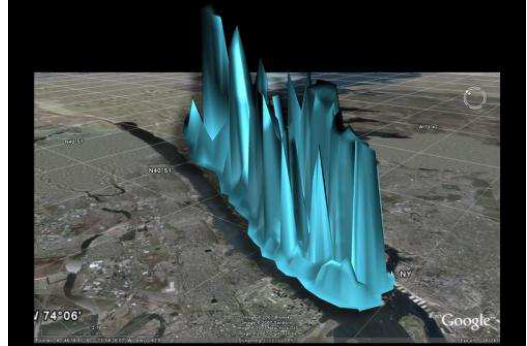
Fig. 4; Population density in New York, http://www.nadiaamoroso.com